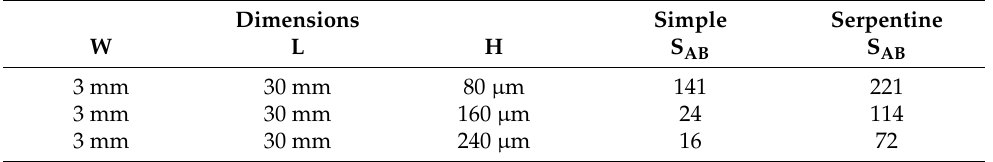
Table 3. Comparison of calculated selectivity (S AB ) by changing channel height of the sensor in the presence of 2.6 ppm acetone and ethanol gases in both the serpentine and simple models. Dimensions Simple